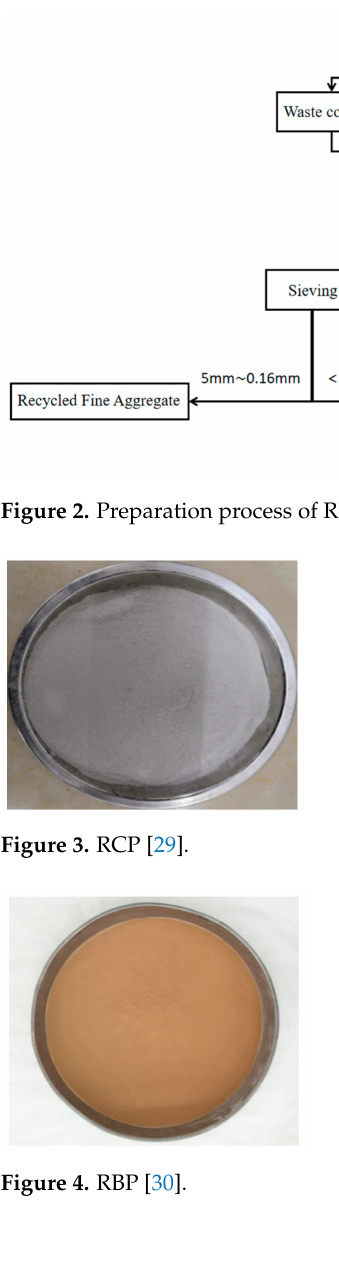
Figure 1. Process of industrial preparation of RP.